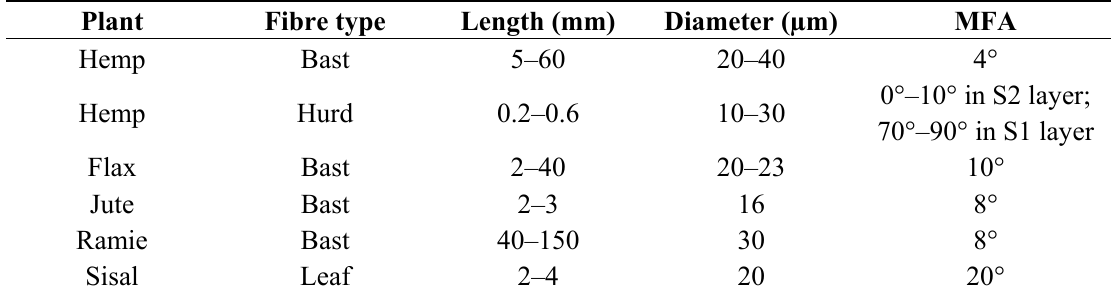
Table 2. Summary of the main physical parameters of fibres from fibre crops (adapted from [116]). MFA stands for microfibril